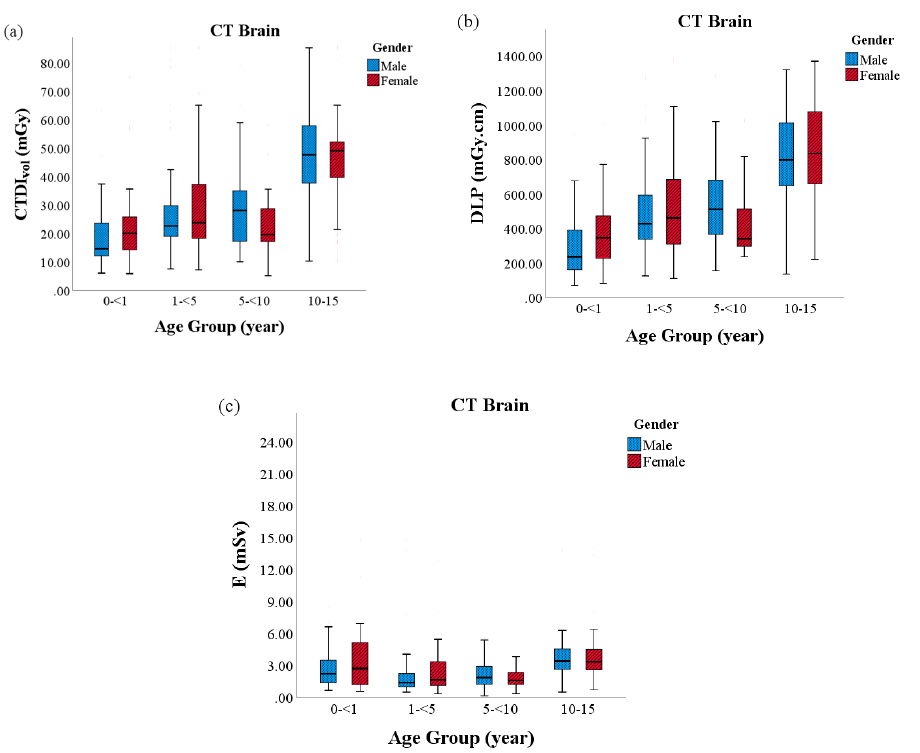
Figure 2. The radiation doses between sex and age in CT brain: ( a ) volume computed tomography dose index (CTDI vol ); ( b ) dose length product (DLP); and, ( c ) effective dose (E).